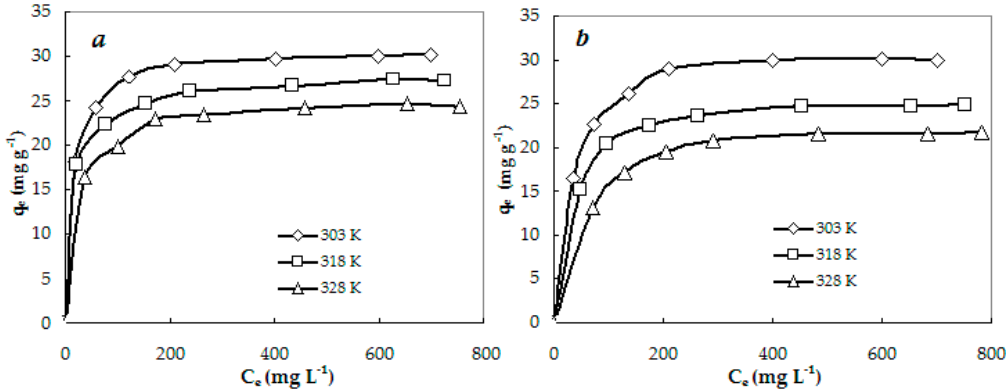
Figure 2. Adsorption isotherms of Acid Red (AR) ( a ) and Acid Orange (AO) ( b ) on CS-CP at different temperatures.